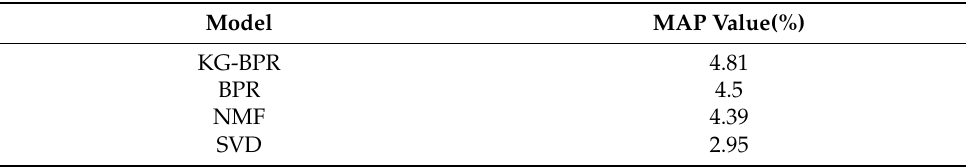
Table 5. Comparison experiment results.